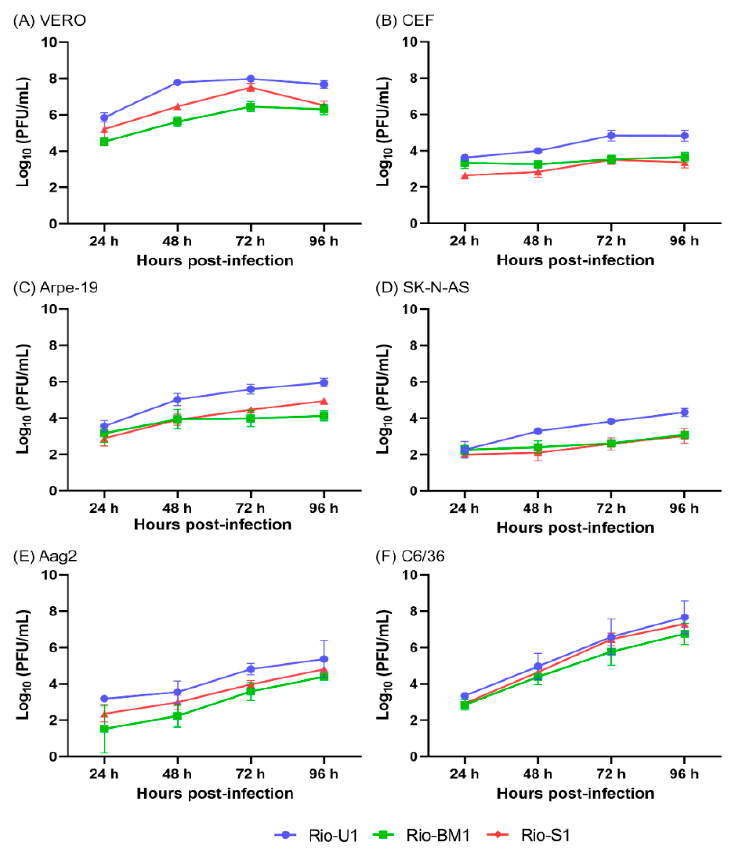
Figure 3. Viral replication of ZIKV Rio-U1, Rio-S1, and Rio-BM1 in different cell lines. The replication profiles were obtained from ( A ) Vero, ( B ) chicken embryo fibroblasts (CEF); ( C ) Arpe-19; ( D ) SK-N-AS; ( E ) C6/36 and ( F ) Aag2 cell lines. Cells were infected with ZIKV isolates at MOI 0.02, and supernatants were used to determine viral titers each day post-infection for 4 days. Statistical analyses applied were One-Way ANOVA with Bonferroni’s multiple comparison test (Figure S4) using GraphPad Prism